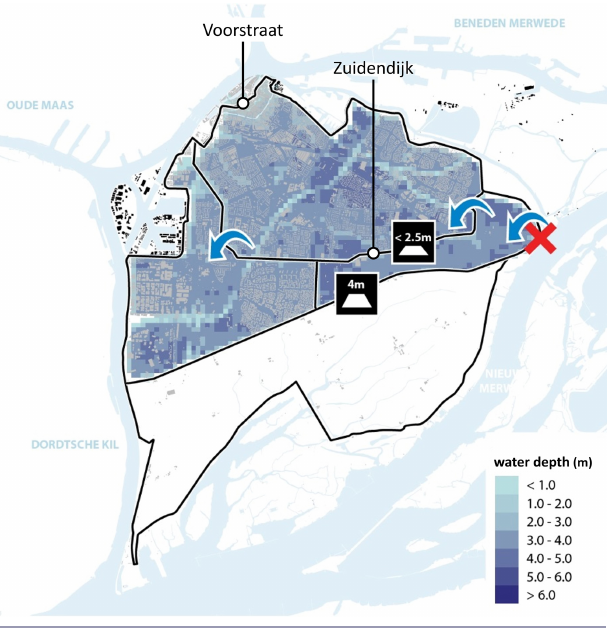
Fig. 3 . Map of the Island of Dordrecht, with the predicted water depths in the urban area for a river-dominated flood event (courtesy: De